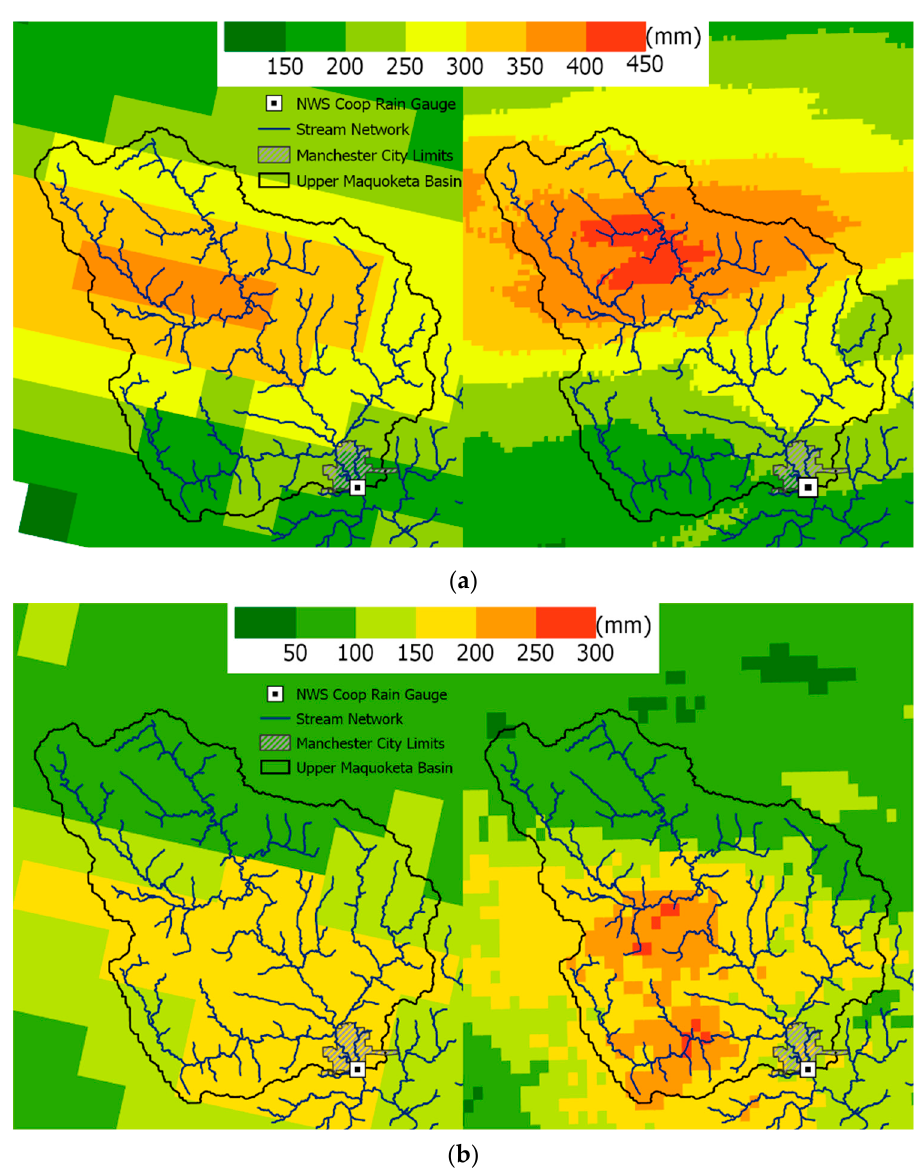
Figure 4 . ( a ) Radar rainfall accumulation estimates over the upper Maquoketa River Basin in mm for the July 2010 storm using Stage IV radar rainfall product (left) and the Iowa Flood Center (IFC) radar rainfall product (right). ( b ) Radar rainfall accumulation estimates for the September 2016 storm using Stage IV (left) and MRMS radar rainfall product (right).